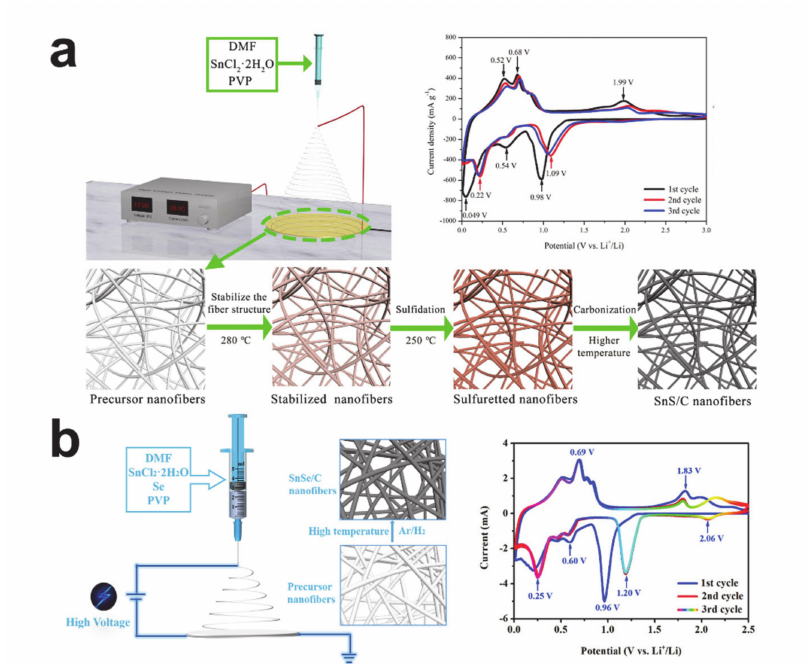
Figure 17. Tin chalcogenide / carbon composite anode materials. ( a ) SnS / carbon composite nanofibers (reprinted with permission from [199]; copyright 2019 Elsevier) and ( b ) SnSe / carbon composite nanofiber (eprinted with permission from [200]; copyright 2020